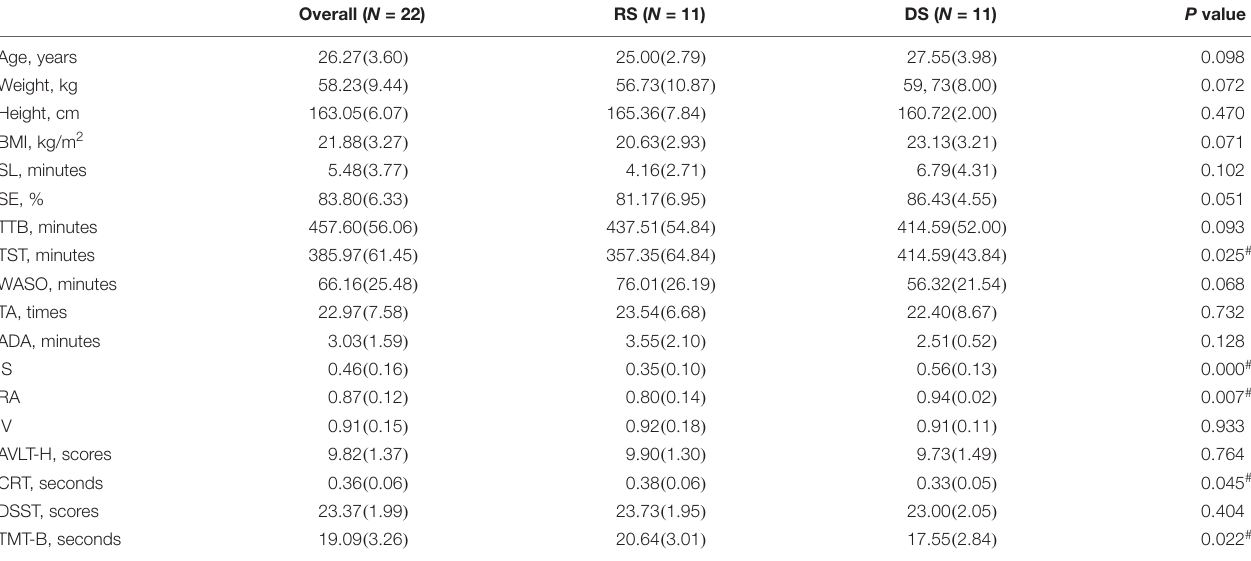
TABLE 1 | Clinical and demographic characteristics of the nurses in different